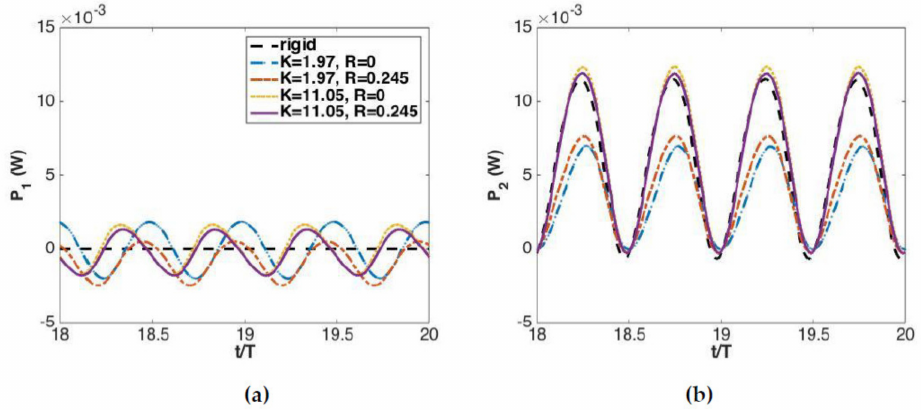
Figure 12. Instantaneous power on ( a ) passive joint and ( b ) active joint.